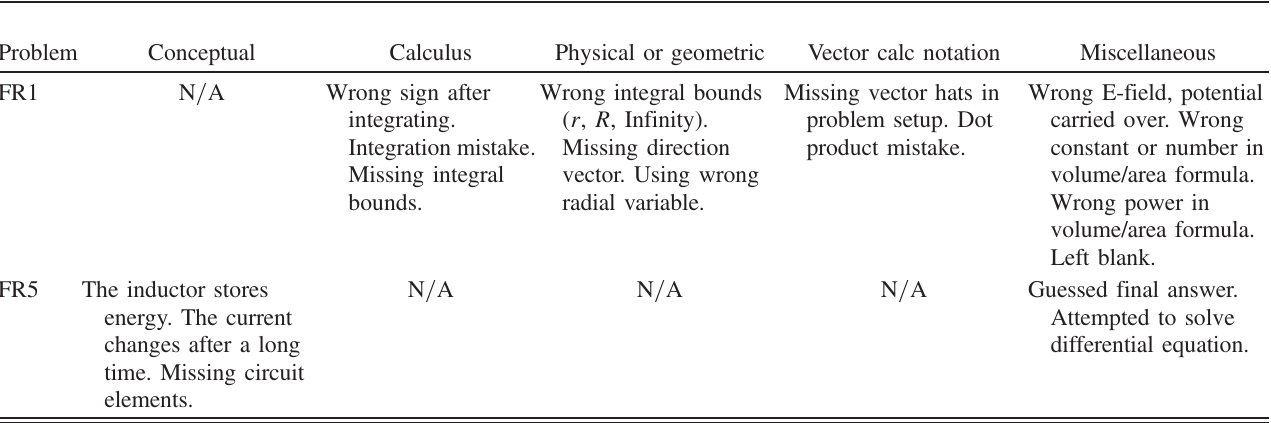
TABLE I. Errors identified in the first and fifth free response questions on the physics 2 final